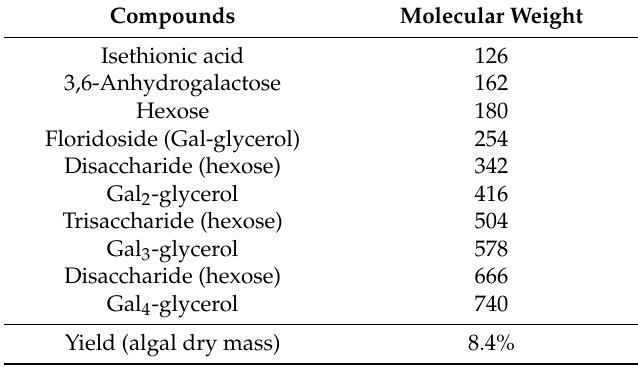
Table 2. Low-molecular-weight compounds identified in the oligosaccharidic fraction of the alkaline extract of G. sesquipedale .